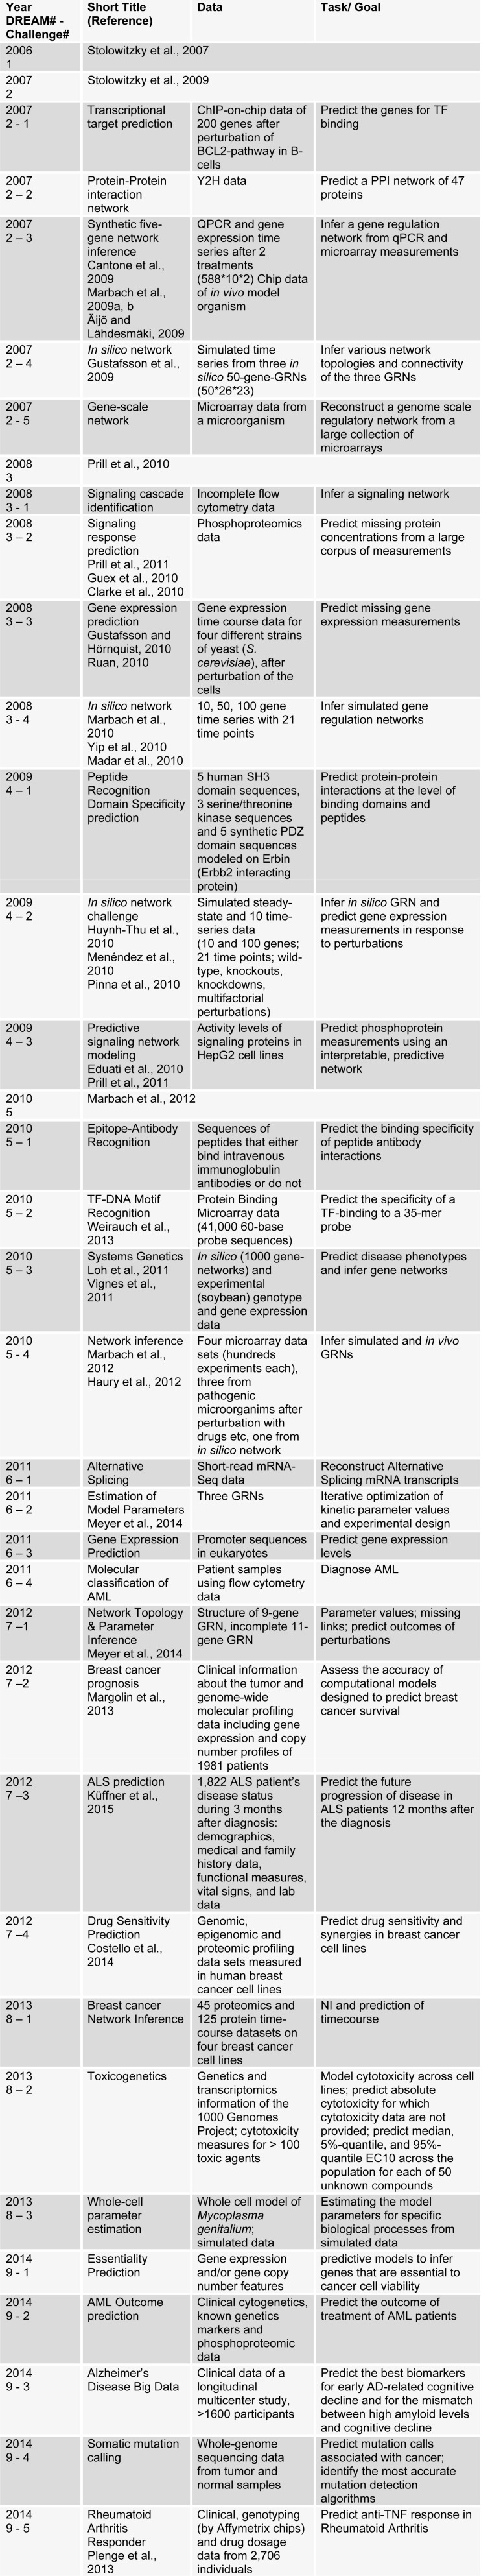
DREAM Challenges. DREAM#: Running number of challenge; Short Title and reference if any; Data given for the challenge